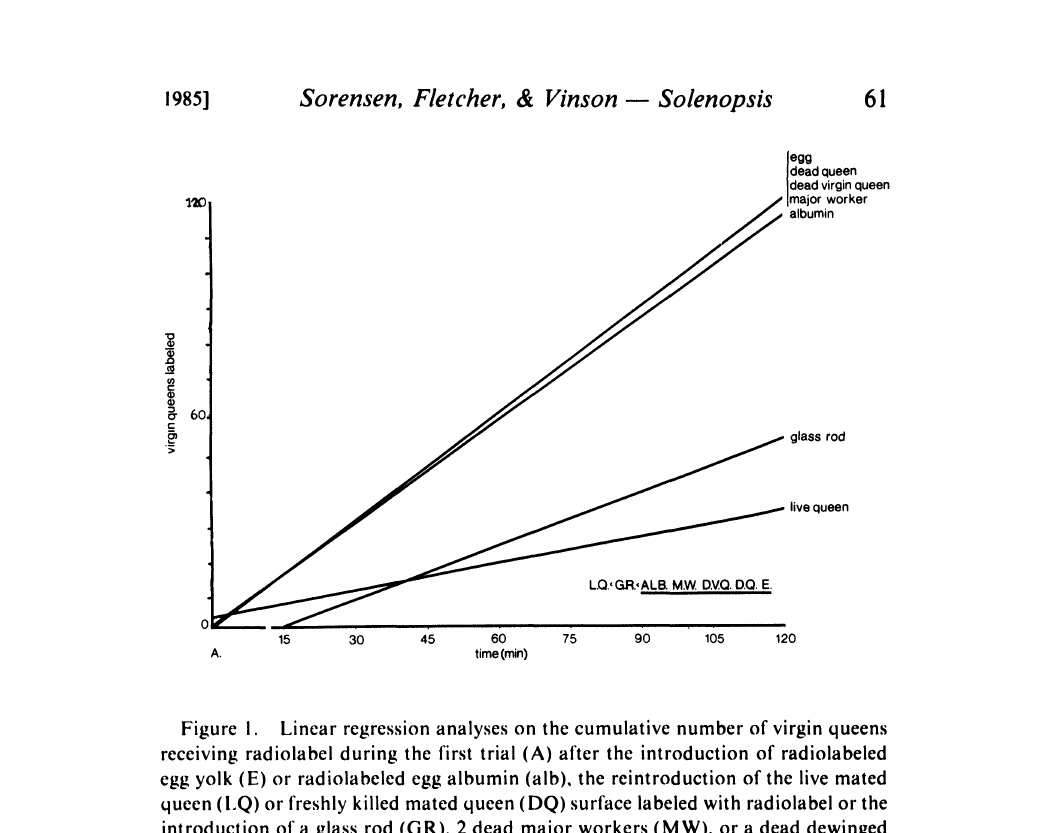
Figure I. Linear regression analyses on the cumulative number of virgin queens receiving radiolabel during the first trial (A) after the introduction of radiolabeled egg yolk (E) or radiolabeled egg albumin (alb), the reintroduction of the live mated queen (I,Q) or freshly killed mated queen (DQ) surface labeled with radiolabel or the introduction ot’a glass rod (GR), 2 dead major workers (MW), or a dead dewinged virgin queen (DVQ) surface labeled with radiolabel. A total of 10 virgin queens were sampled in each colony at 15 min intervals for a total of 120 virgin queens over the 2 h period. Slopes ot" the underlined groups do not differ at p < 0.05 (Newman-Keuls